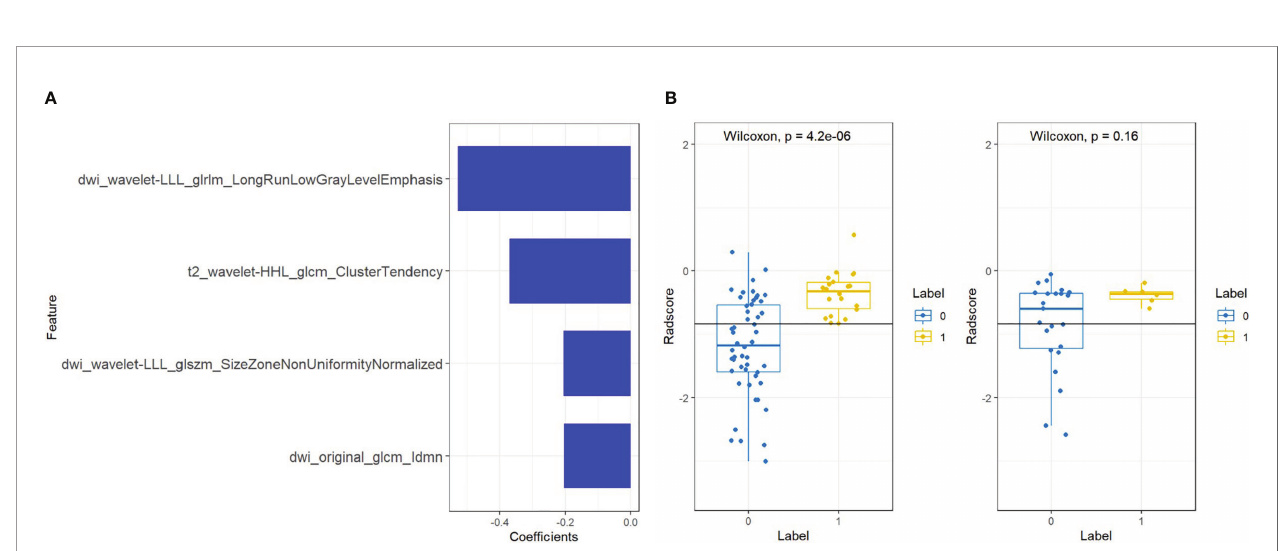
FIGURE 2 | The construction of LASSO regression model. (A) Curve of binomial deviation of biparameter MR radiomics model varying with parameter l . The horizontal axis is the log ( l ) value. The vertical axis represents binomial deviation. The number above represents the number of selected features, and the l at the minimum binomial deviation of the model is the optimal value (vertical dotted line). (B) Biparameter MRI model changing with l . The number above indicates the number offeatures fi ltered out.